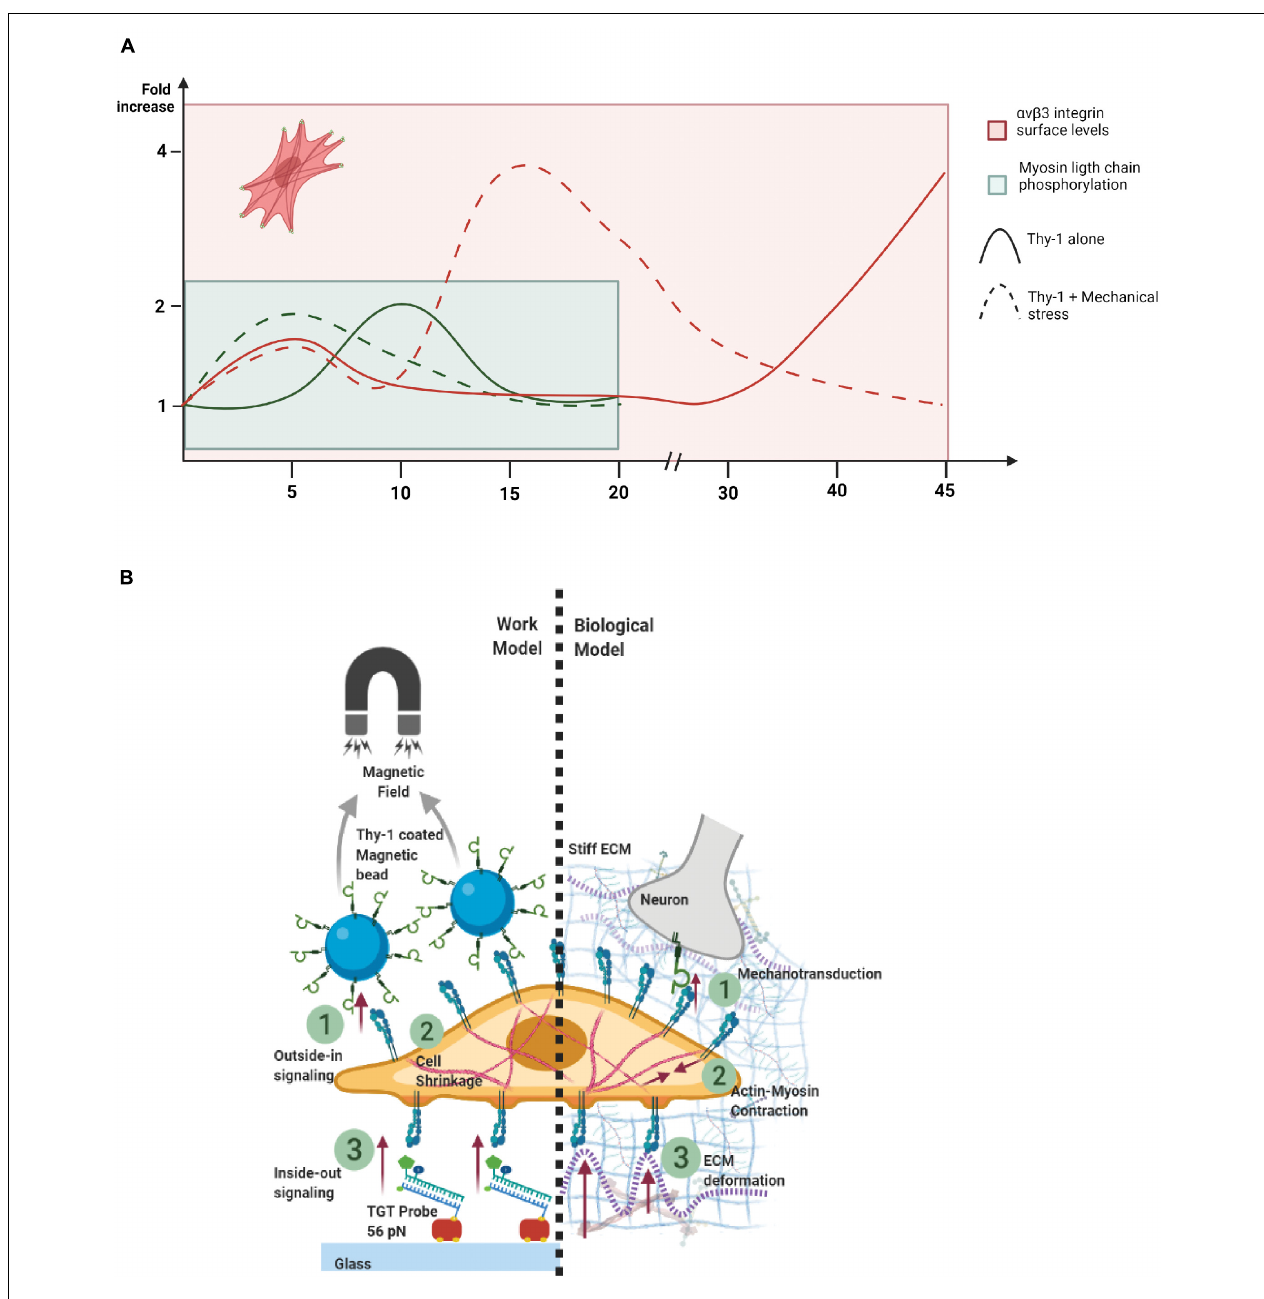
FIGURE 6 | Scheme of outside-in switch in integrin signaling caused by mechanical stress. (A) Summary of the kinetics of astrocyte molecular/cellular responses. Dashed lines show the curve of Thy-1 plus mechanical stress stimulation, solid lines show Thy-1 alone stimulation over time. Red lines represent the kinetics of α V β 3 Integrin surface levels, while green lines show the kinetics followed by the Myosin Light Chain phosphorylation. Red cell, with darker red lines and green spots, represents a cell with an increased number of focal adhesions and stress fibers at 5 min of stimulation compared with the non-stimulated control. (B) Work Model: (1) Outside-in signaling through α V β 3 Integrin stimulated chemically by Thy-1 and mechanically by a magnetic field. (2) Cellular shrinkage as a response to integrin activation. (3) Inside-out signaling through integrins, where the astrocyte exerts tension force to the TGT probe-coated glass. Biological Model: (1) Mechanotransduction through the α V β 3 Integrin, triggered by a stiff ECM (cell-matrix) and neuronal Thy-1 (cell-cell) interaction, leading to (2) Actin-myosin contraction and traction force exerted by the astrocyte through Integrins generate (3) ECM deformation. Both figures were created with